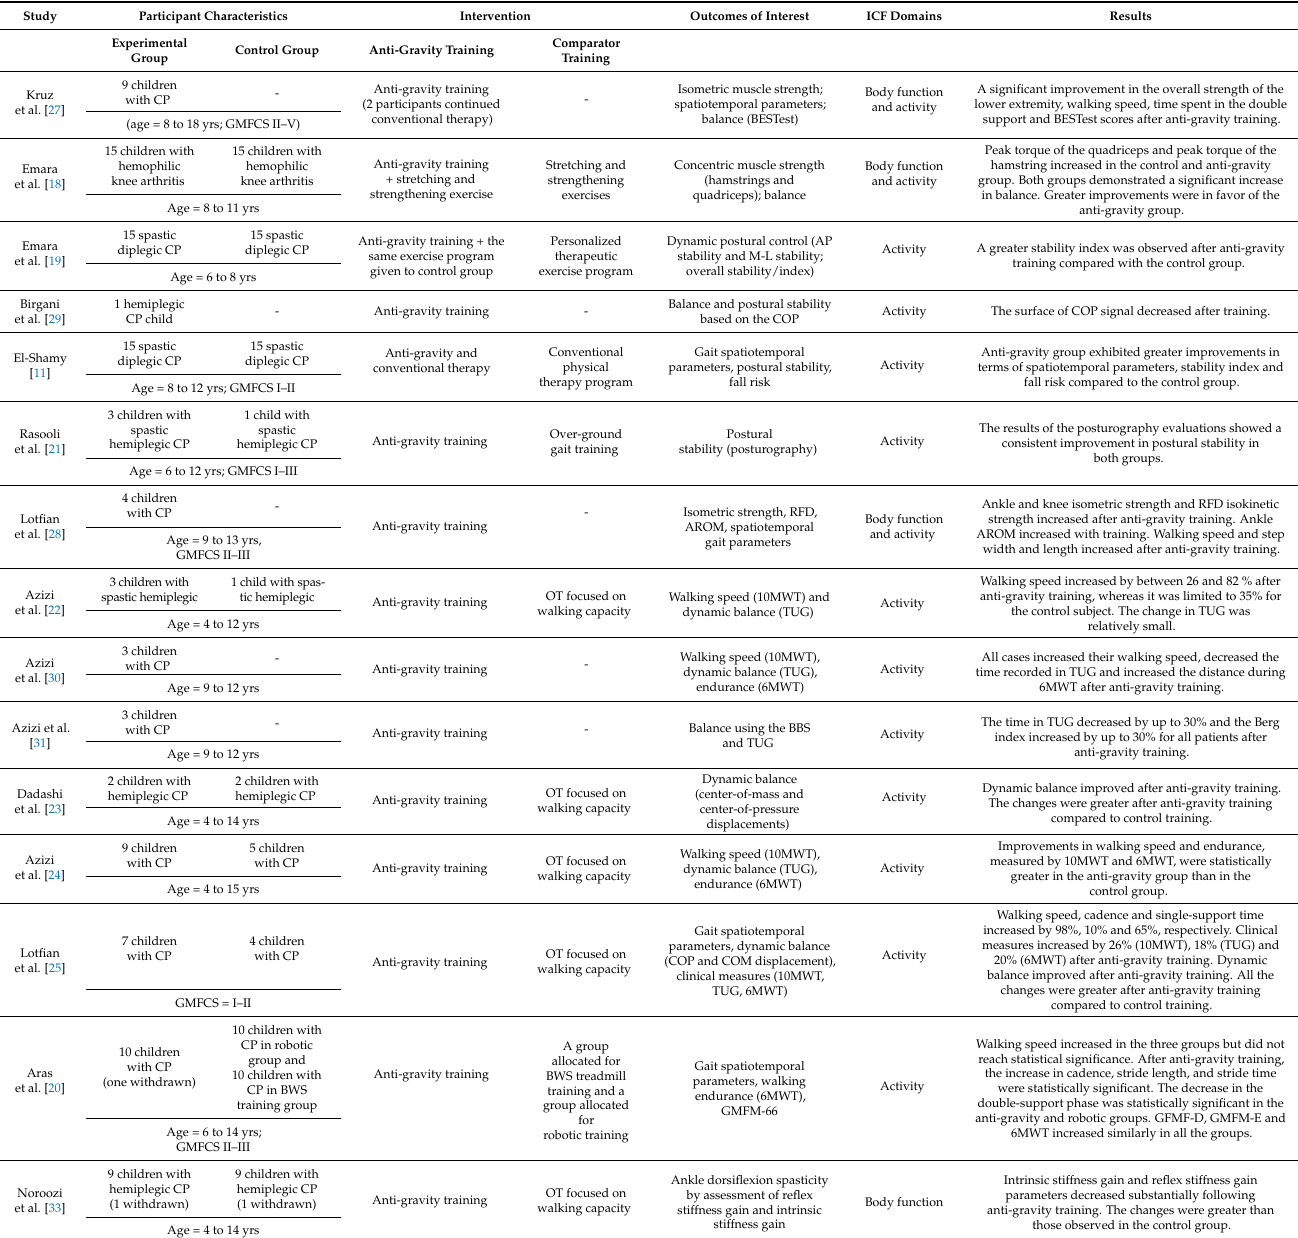
Table 2. Summary of participant characteristics and